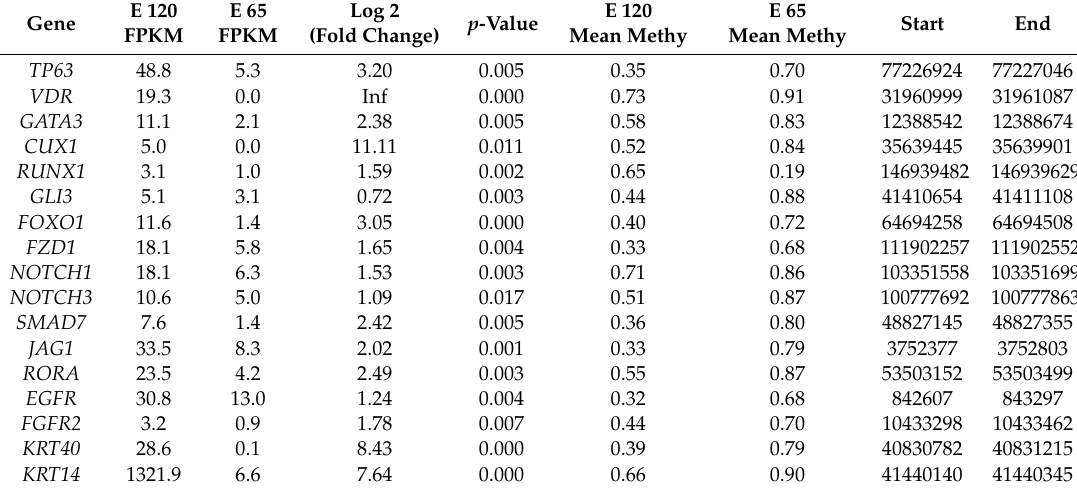
Table 1. The genes associated with hair follicle di ff erentiation under the control of DNA